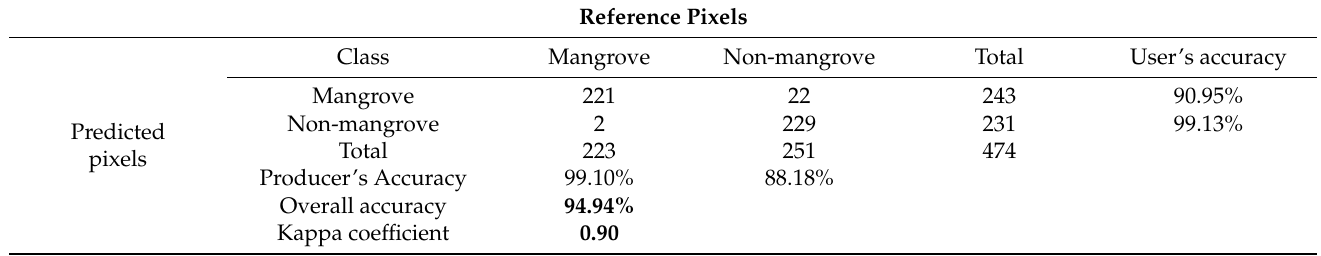
Table 2. The confusion matrix for accuracy assessment of mangrove forest using Landsat 8-OLI in 2020.